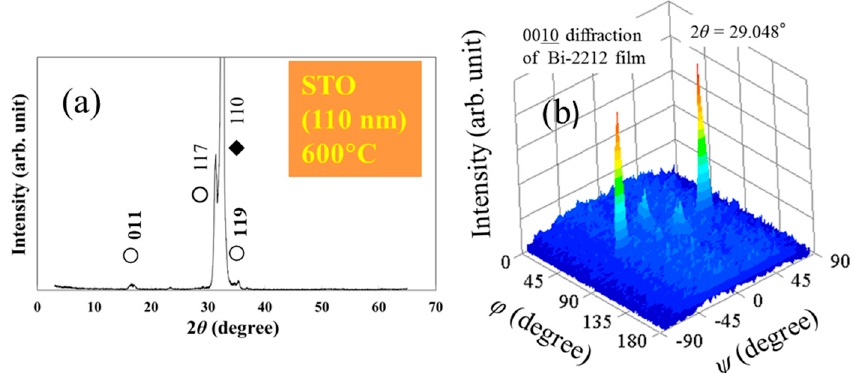
Figure 2. ( a ) X-ray diffraction patterns (2 θ - θ ) and ( b ) ϕ - ψ scans ((0010) plane, 2 θ = 29.048 ◦ ) for the non c -axis Bi-2212 thin film grown at 600 ◦ C on flat (110) SrTiO 3 substrate. Phases are: substrate. Positions ( φ , ψ ) of the peaks in ( b ) are: (90 ◦ , 45 ◦ ) and (90 ◦ , − 45 ◦ ).